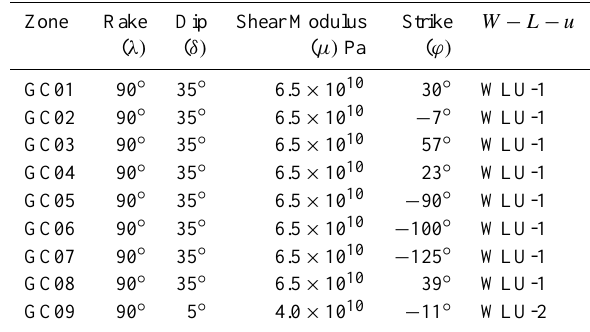
Table 4. Summary of properties for the Gulf of Cadiz tsunamigenic source